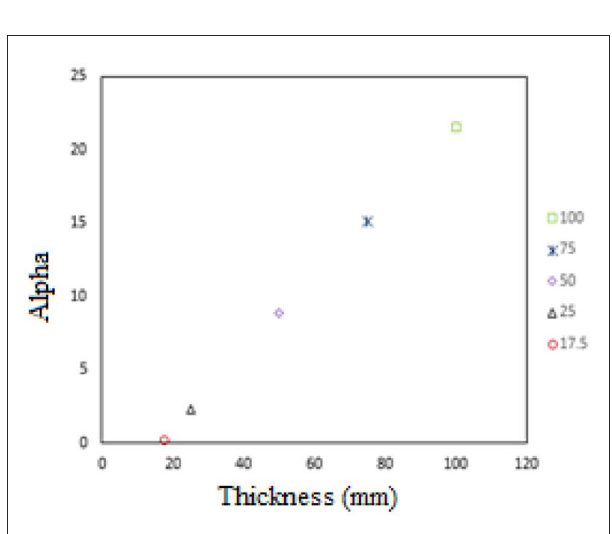
FIGURE13 Graph of α vs. various thicknesses for PVA-C 5%.